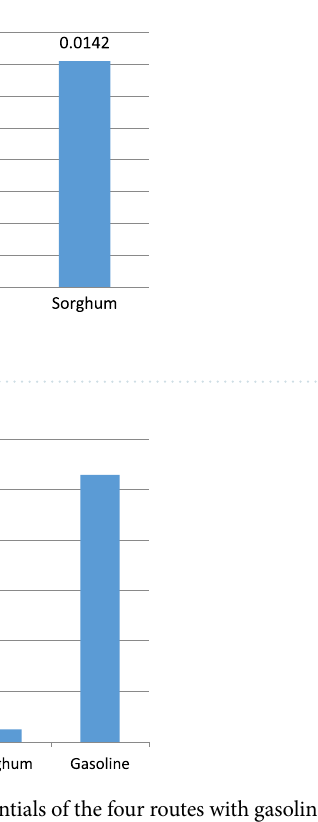
Figure 8. Comparison of the global warming potentials of the four routes with gasoline.